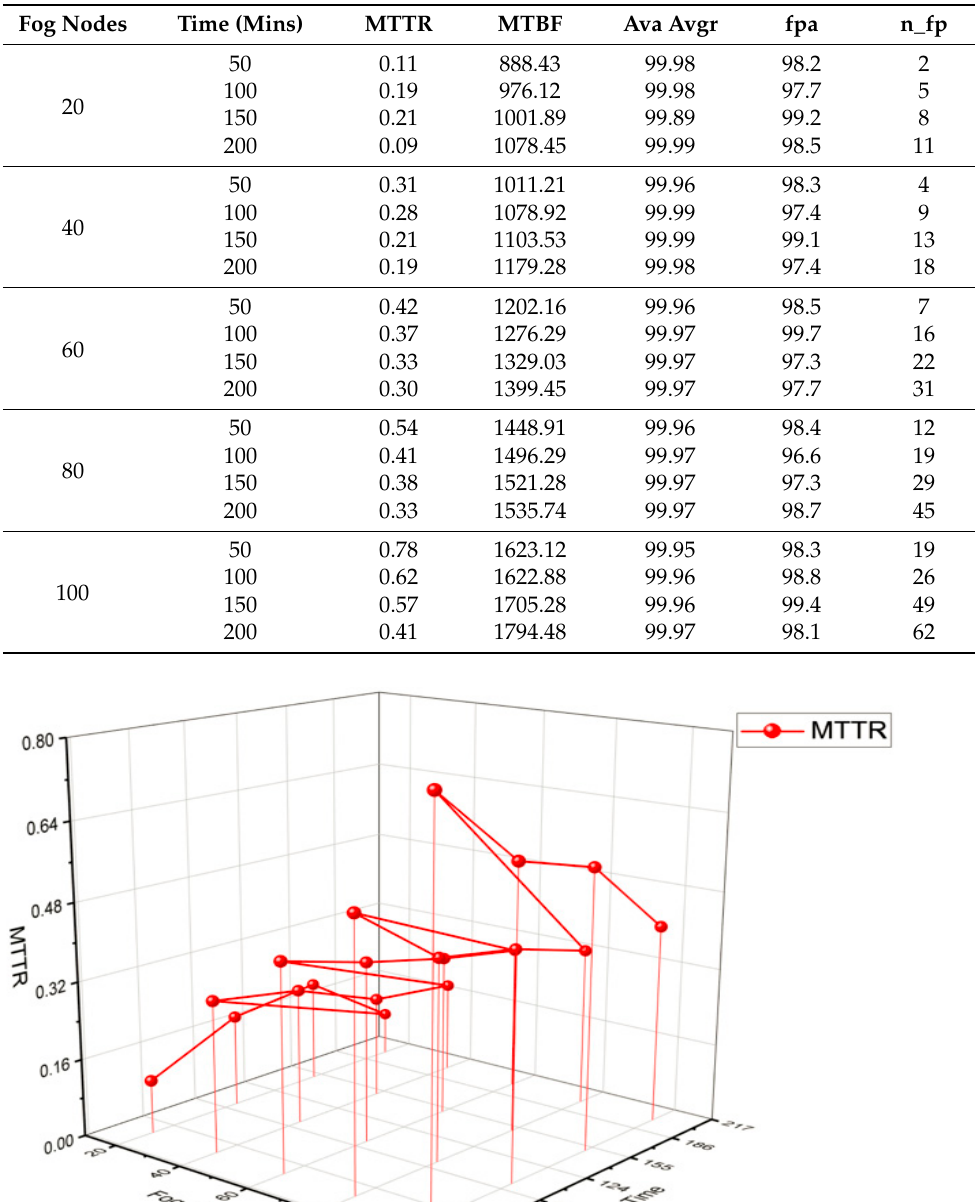
Table 7. Values of MTTR and